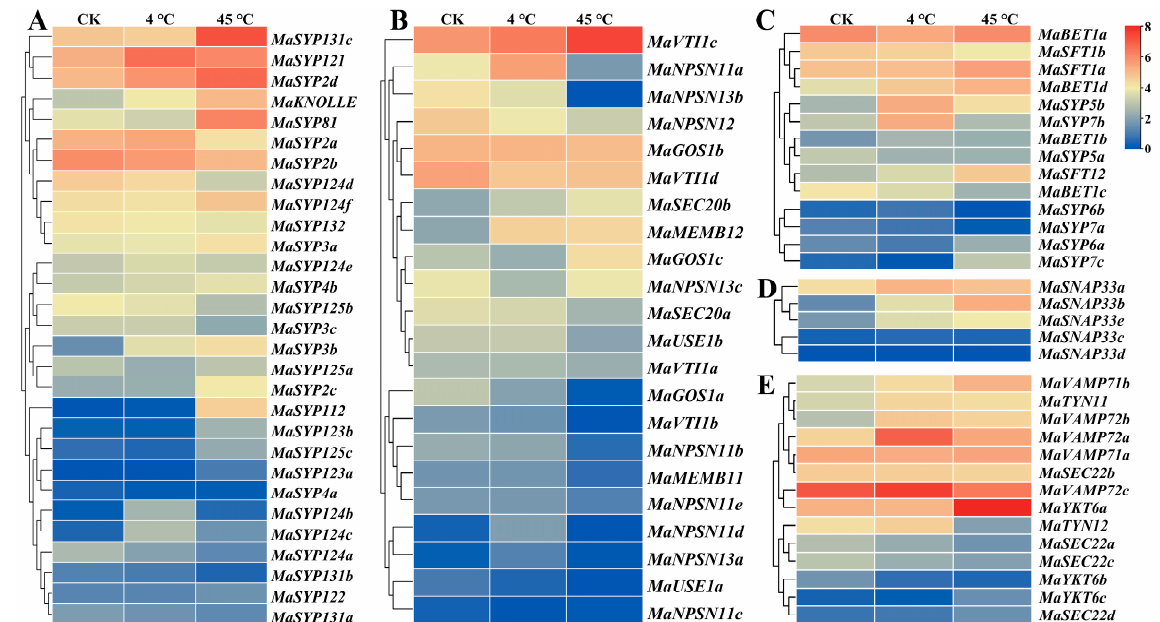
Figure 6. Expression heatmap for the expression of MaSNARE genes in leaves under low (4 °C) and high temperature (45 °C) treatments. ( A – E ): Qa, Qb, Qc, Qbc and R subfamily, respectively. CK: leaves from plants grown at 28 °C. Average FPKM values of three biological replications were used for the heatmap drawing. The redder the color, the higher the expression level; the bluer, the lower the expression level.